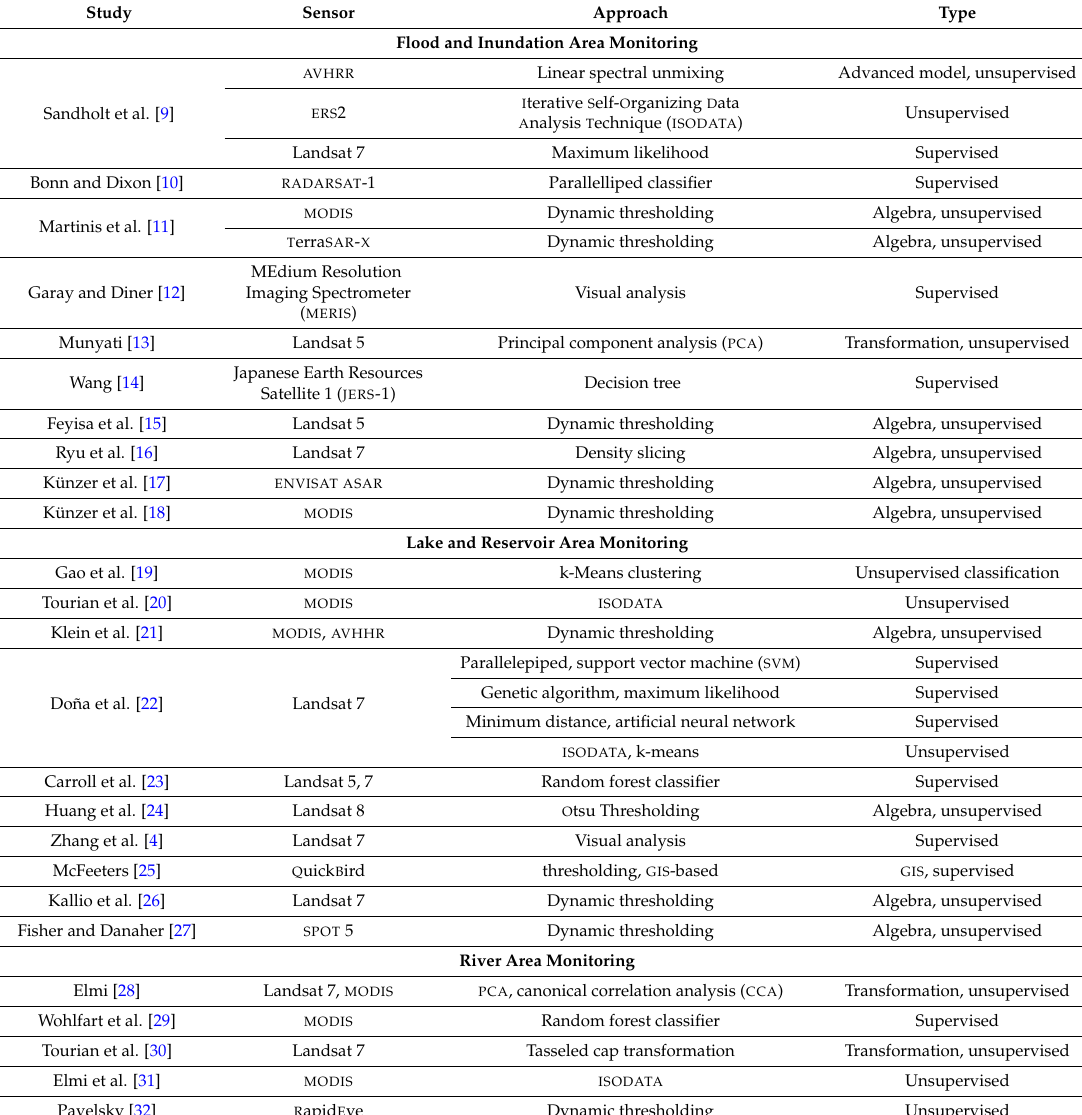
Table 1. Overview of studies using satellite images to extract the water bodies. AVHRR: Advanced Very High Resolution